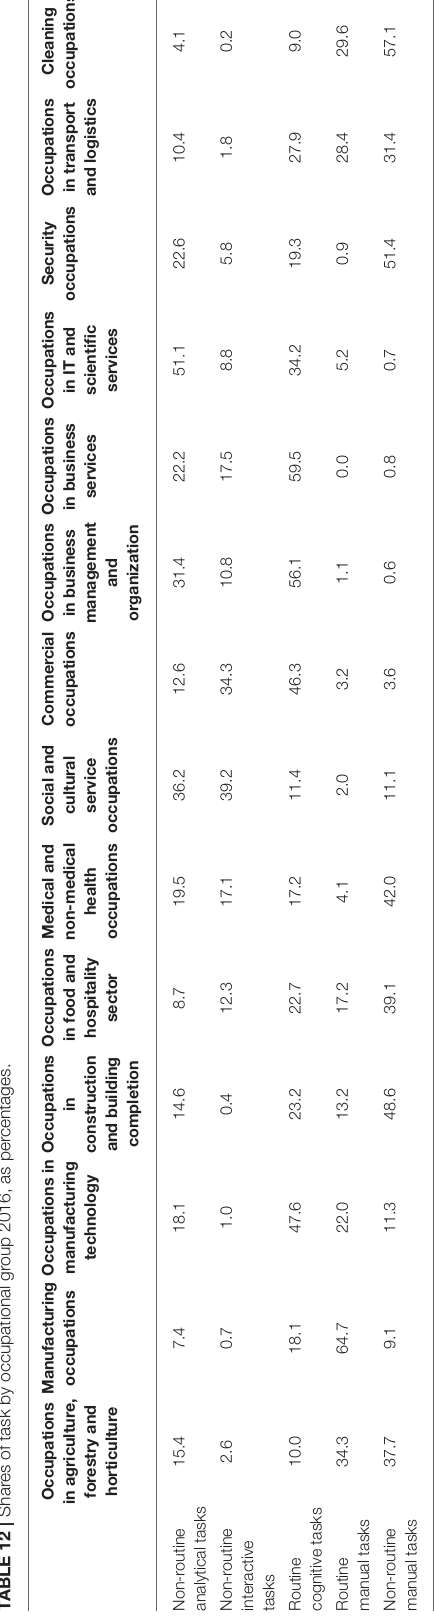
TABLE 11 | Comparison of the marginal effects of the three estimations.